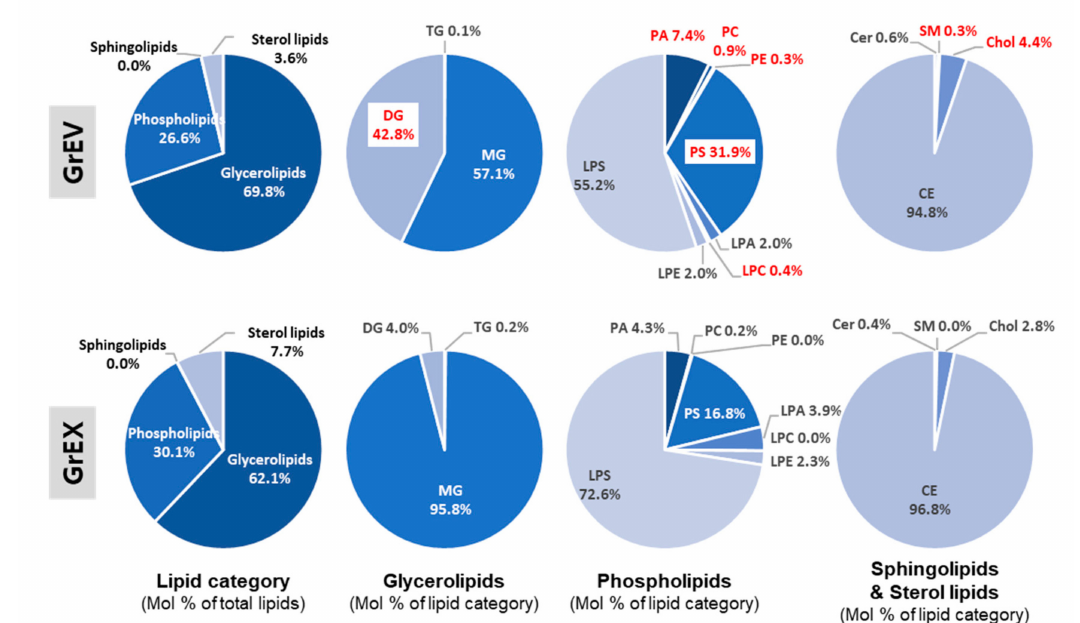
Figure 8. Pie diagrams for lipidomic compositions and relative proportions in GrEVs (upper) and GrEXs. The composition of each lipid category or lipid class (glycerolipids, phospholipids, and sphingolipids/sterol lipids) is expressed as the mol% of total lipids or the mol% of each lipid category. Lipid classes with considerable changes in GrEVs compared to GrEXs are indicated with red colored fonts; 100% by lipid class in GrEVs or GrEXs corresponds to the percentage of each lipid in lipid